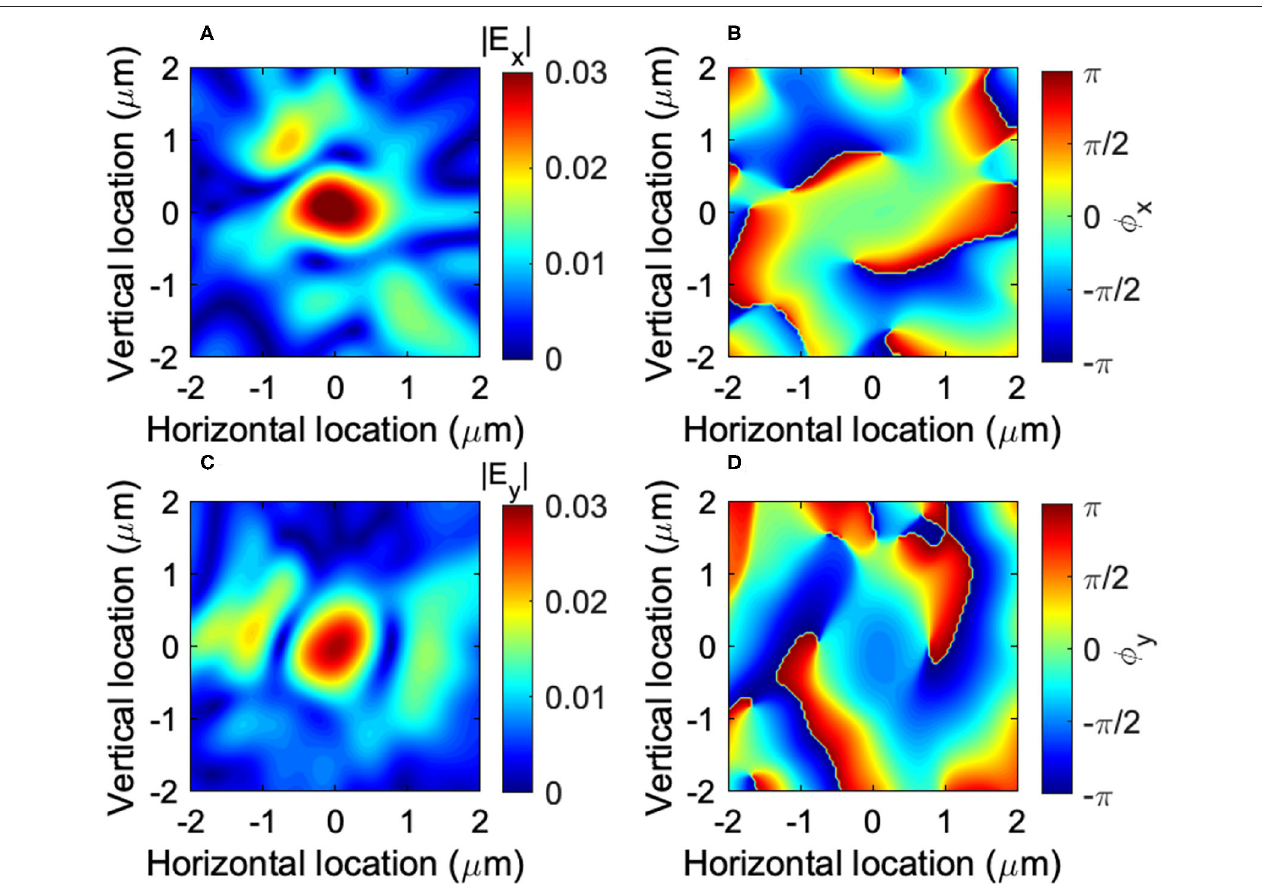
FIGURE 4 | Right-circularly-polarized state, generated from the gear of N obtained at z 1 µ m above the gear. (A) The amplitude ( = the horizontal electric field E y . There is no node in the modes, such that there is no OAM. They show E y (cid:8) state, | i spin